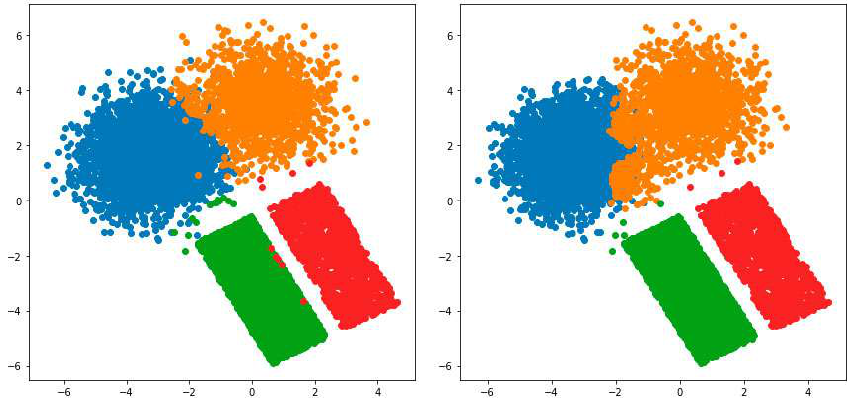
Figure 5. Example of instances from the DS 6 , classified by HPFuzzNDA (the left graph) and PFuzzND (the right graph) algorithms.